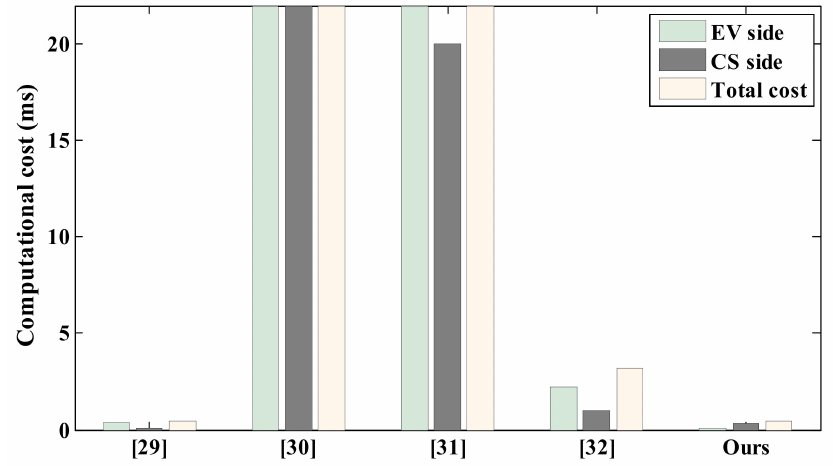
Figure 5. Comparative computational cost for each protocol